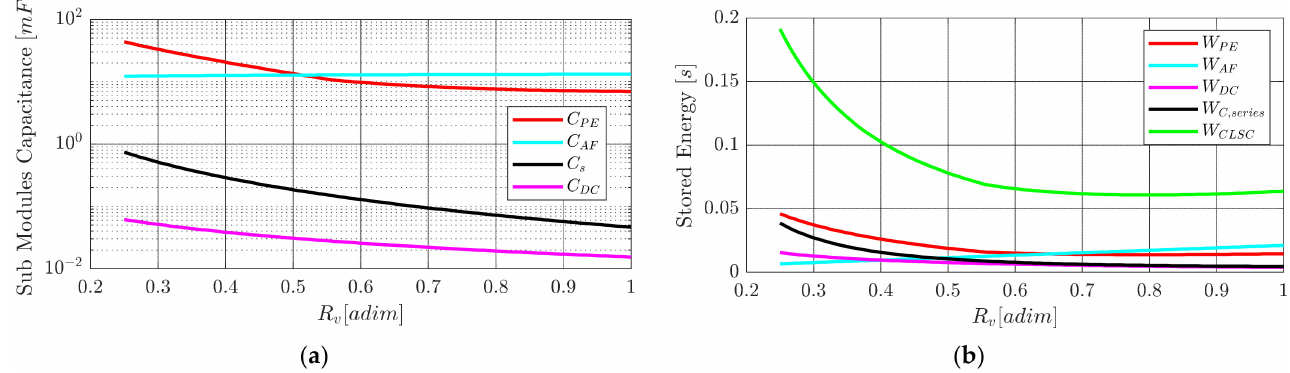
Figure 18. Open-delta CLSC SM capacitors ( a ), and stored energy ( b